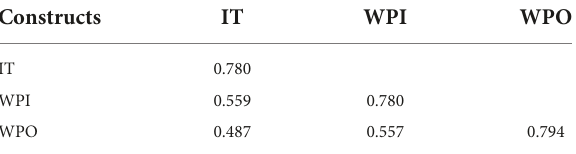
TABLE 2 Discriminant validity.